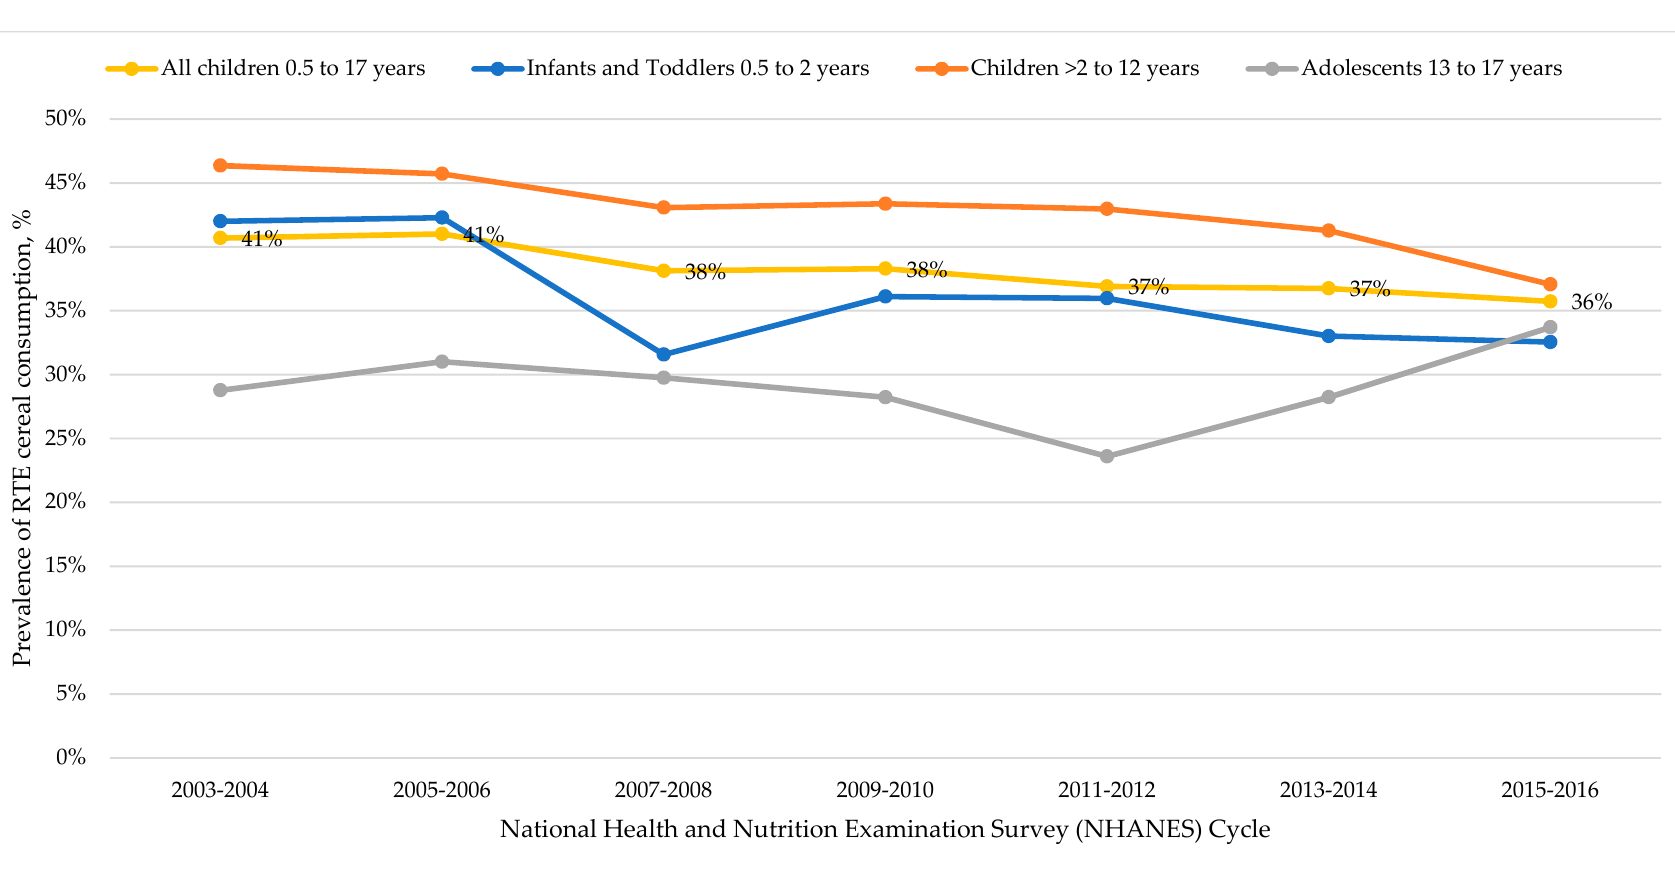
Figure 1. Prevalence of ready-to-eat (RTE) cereal consumption in the National Health and Nutrition Examination Survey (NHANES) from 2003-2004 to 2015-2016 among infants and toddlers 0.5 to 2 years (blue marker and line); children >2 to 12 years (orange marker and line); adolescents aged 13 to 17 years (gray marker and line); and for all children aged 0.5 to 17 years (yellow marker and line). See Table S3 for the number of participants for each age group and time point.